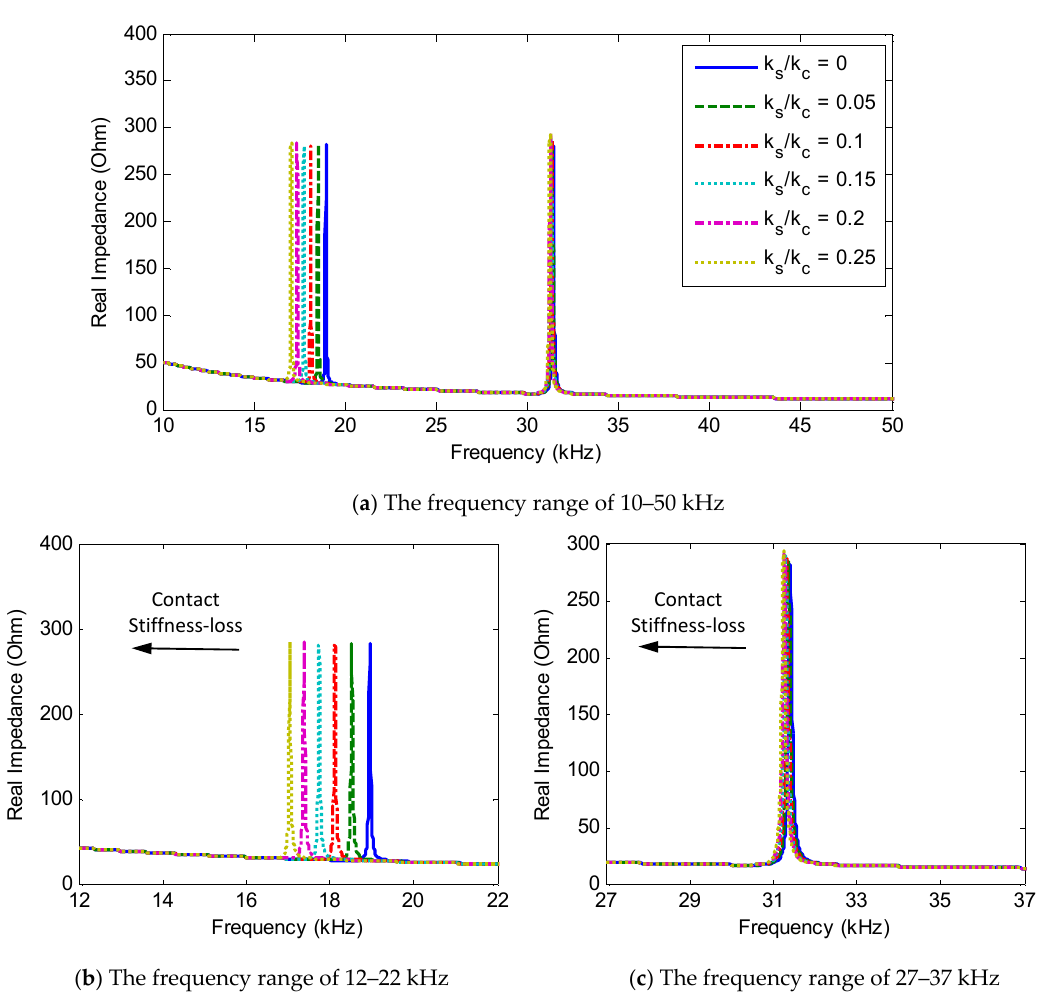
Figure 4. Changes in the impedance responses of the impedance model under contact stiffness-loss.